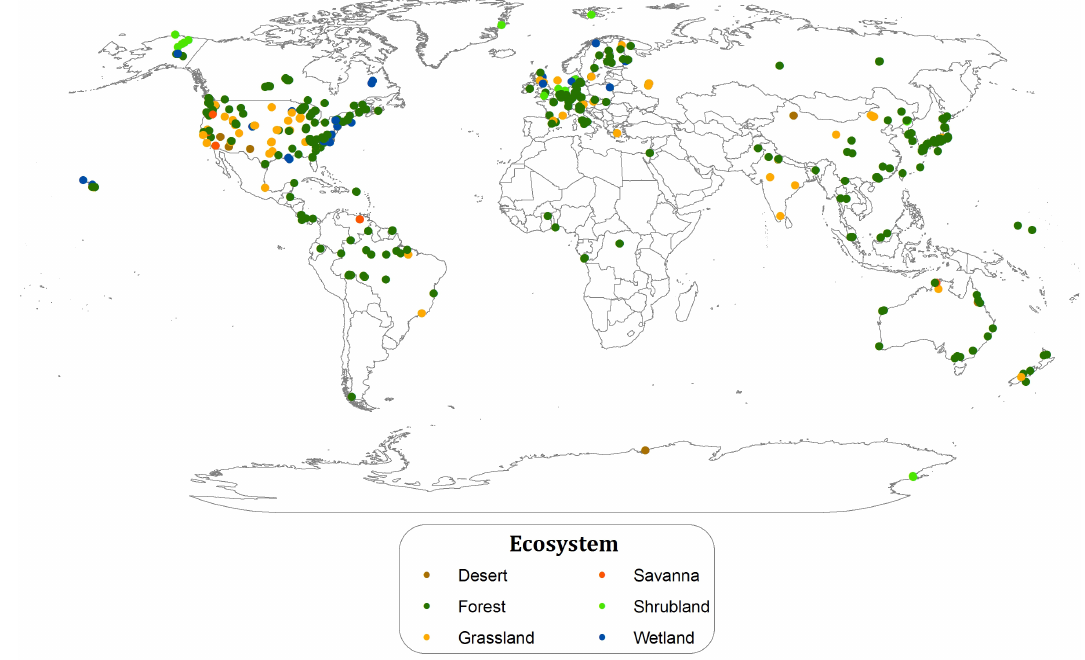
Fig. 2. Location of SRDB database observations (dots), by ecosystem type. A Google Earth™ data layer is included with the database for more detailed spatial views.